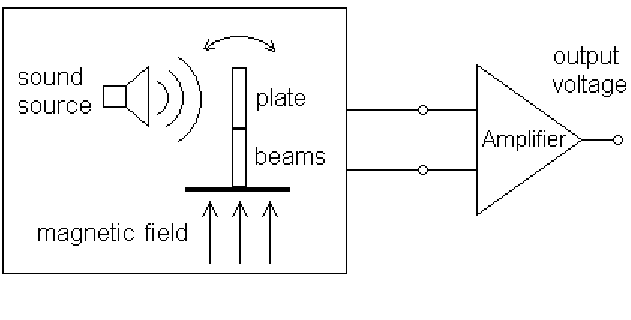
Figure 8. Electrodynamic